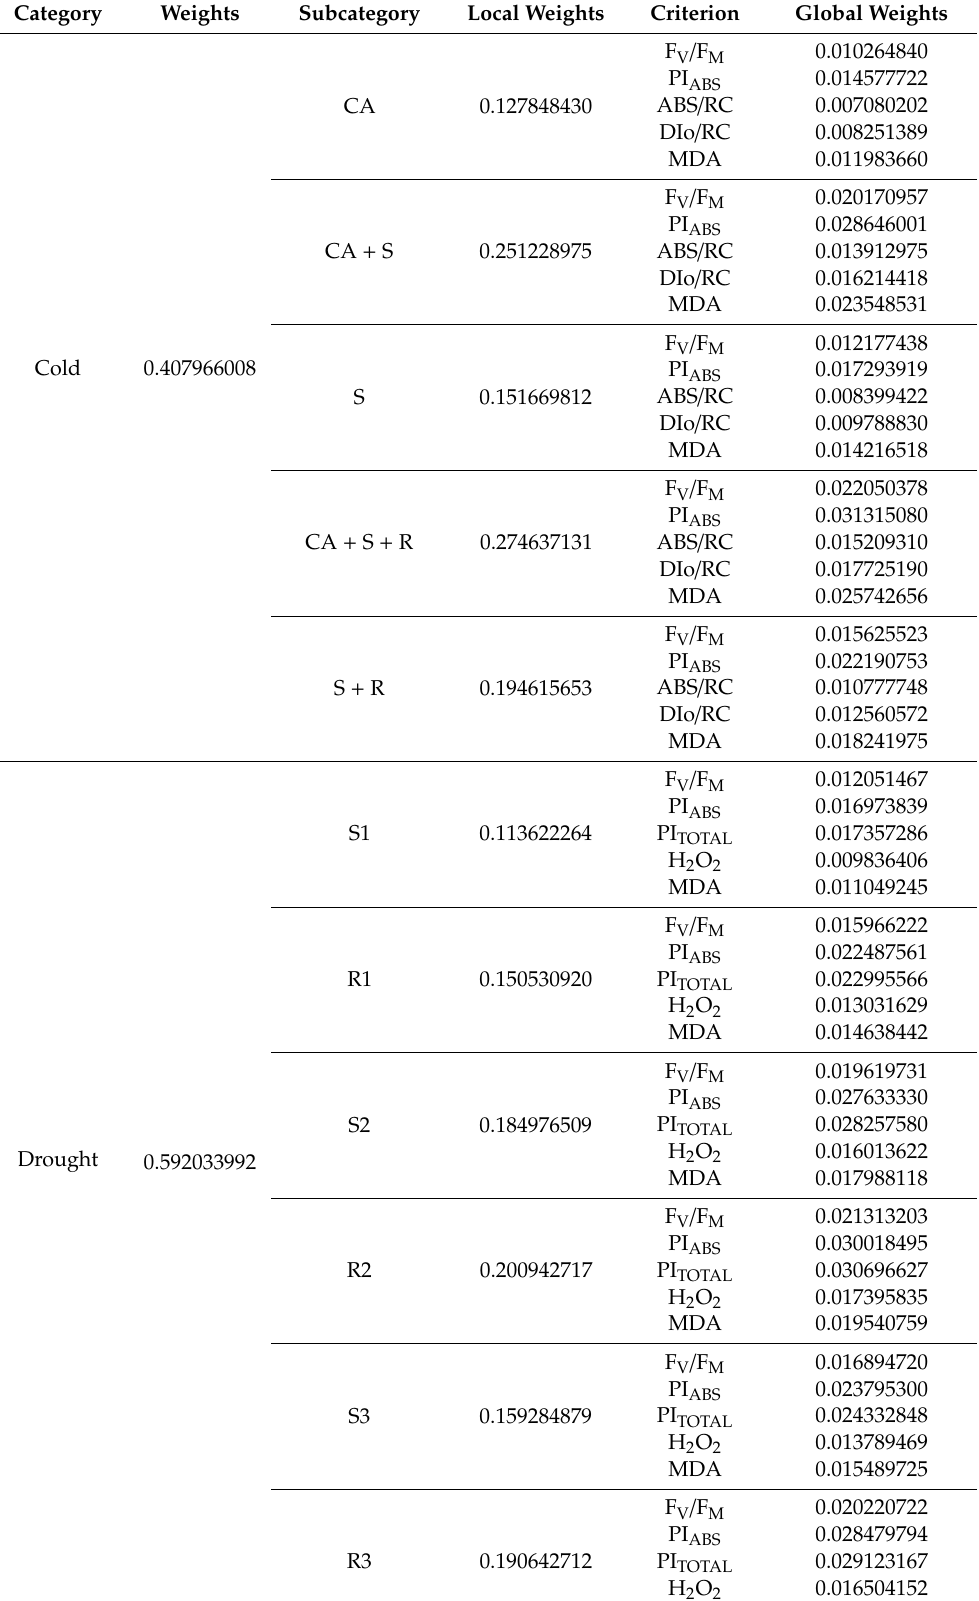
Table 13. Criterion